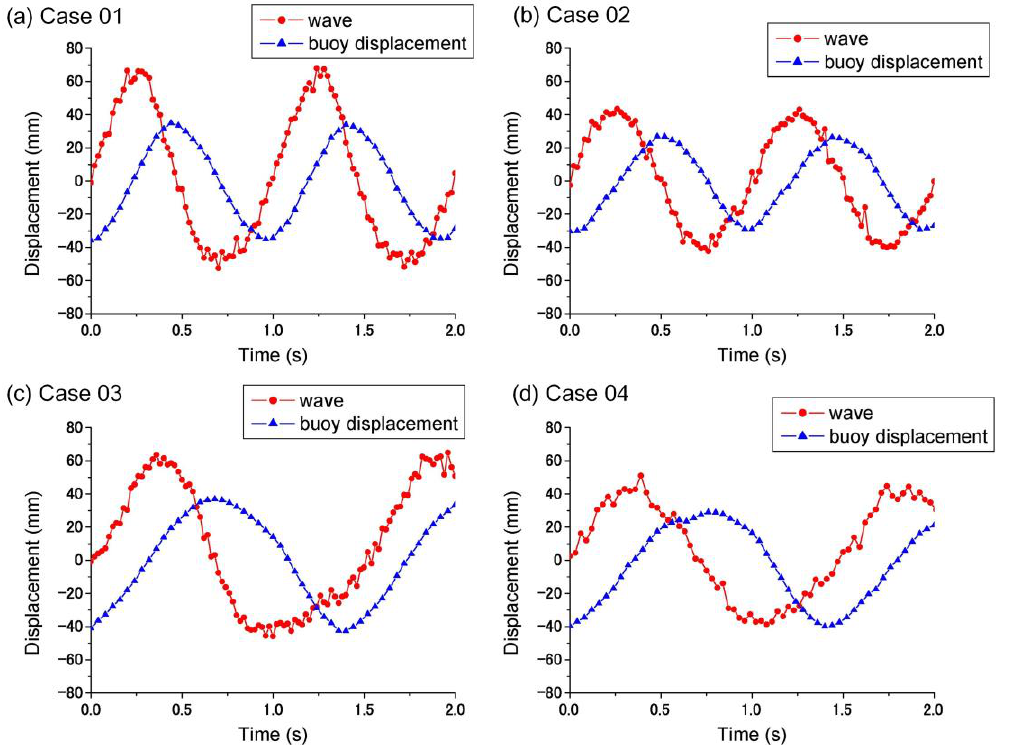
Figure 6. Wave height and buoy displacement.